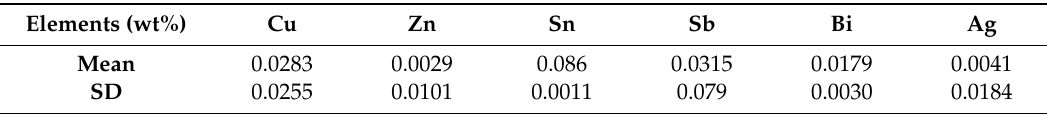
Table 1. Mean and standard deviation (SD) values of common impurities obtained from elemental analysis of 80 different scrap melt batches.